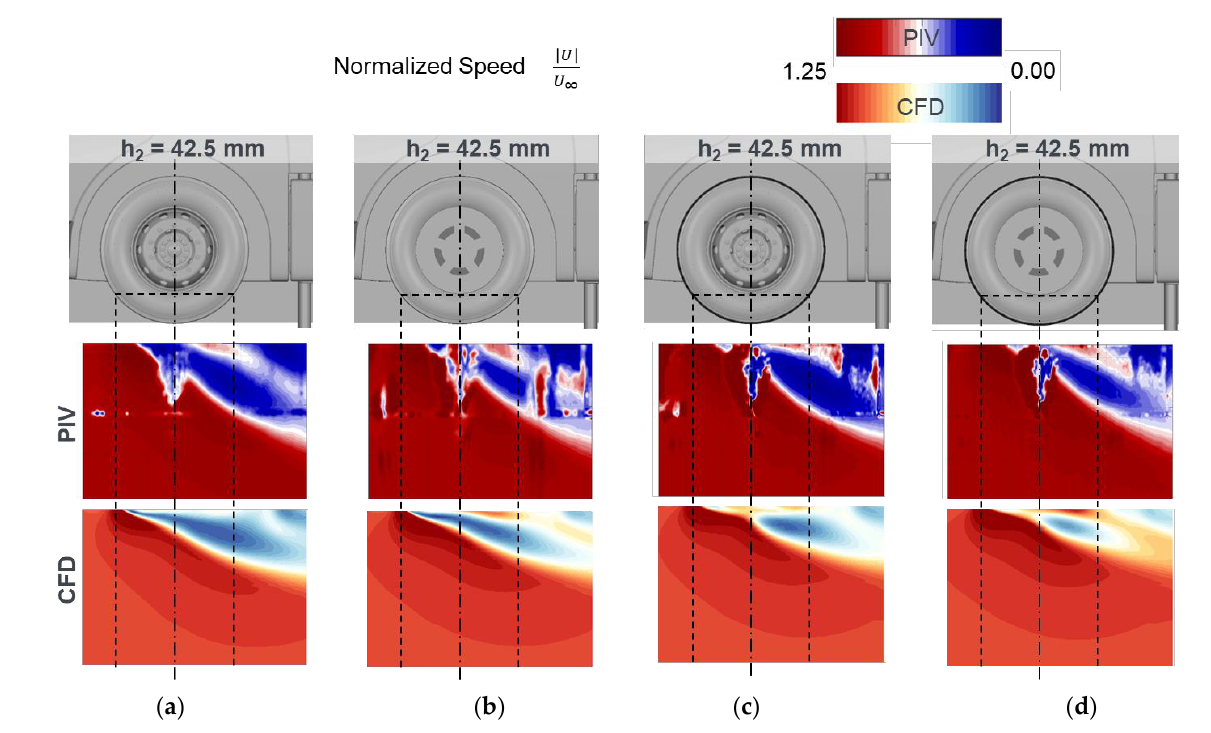
Figure 9. Flow field comparison: PIV measurements and CFD results at the lower 340 mm × 150 mm plane for the front wheel with different treads and rim shapes. ( a ) Grooves with standard rim; ( b ) Grooves with eco rim; ( c ) Treaded pattern with standard rim; ( d ) Treaded pattern with eco rim.